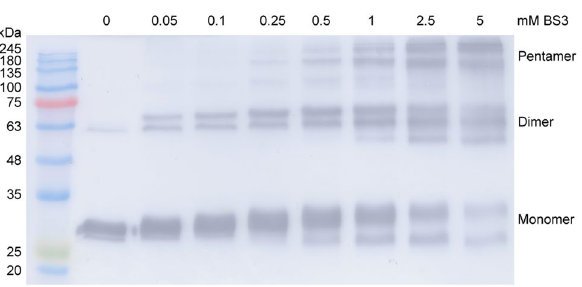
Figure 4. Crosslinking of Pm FREP CRD with bis(sulfosuccinimidyl)suberate (BS3) at various concentrations. Pm FREP was detected by western blot probed with an anti-His 6